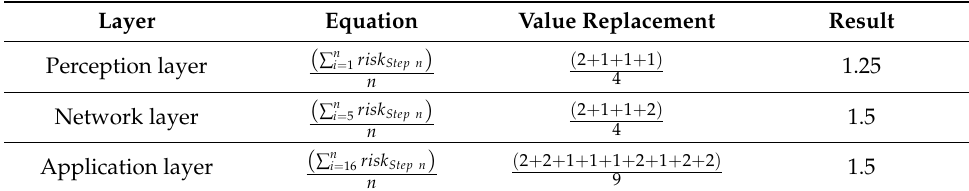
Table 23. Attack surface.